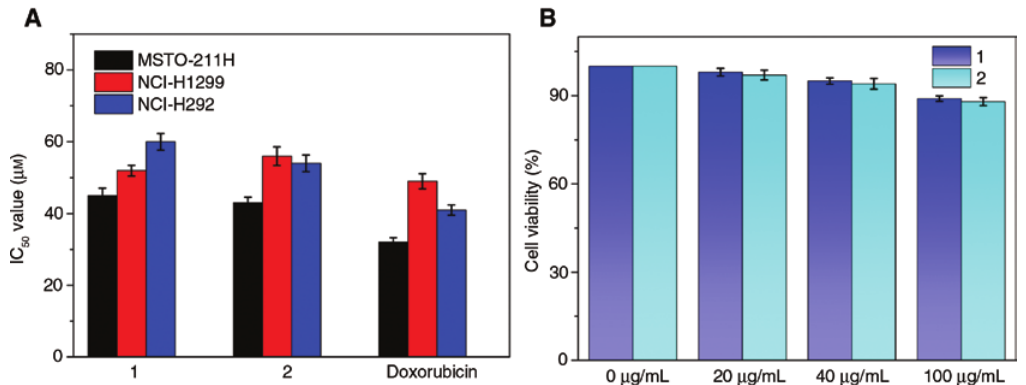
values of the two metal-organic complexes and doxorubicin against MSTO-211H, NCI-H1299 and NCI-H292 cells (A). Figure 5: The IC 50 The cytotoxicity of 1 and 2 toward the human epithelial cells